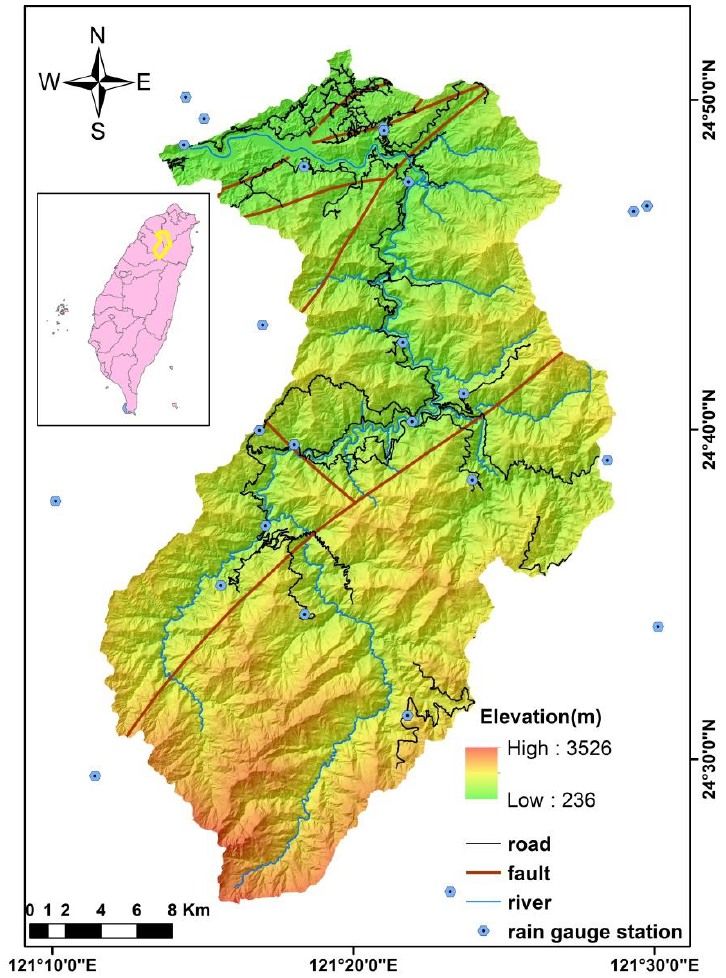
Figure 1. Elevation, road, fault, river system, and rain gauge station in the Shihmen watershed.